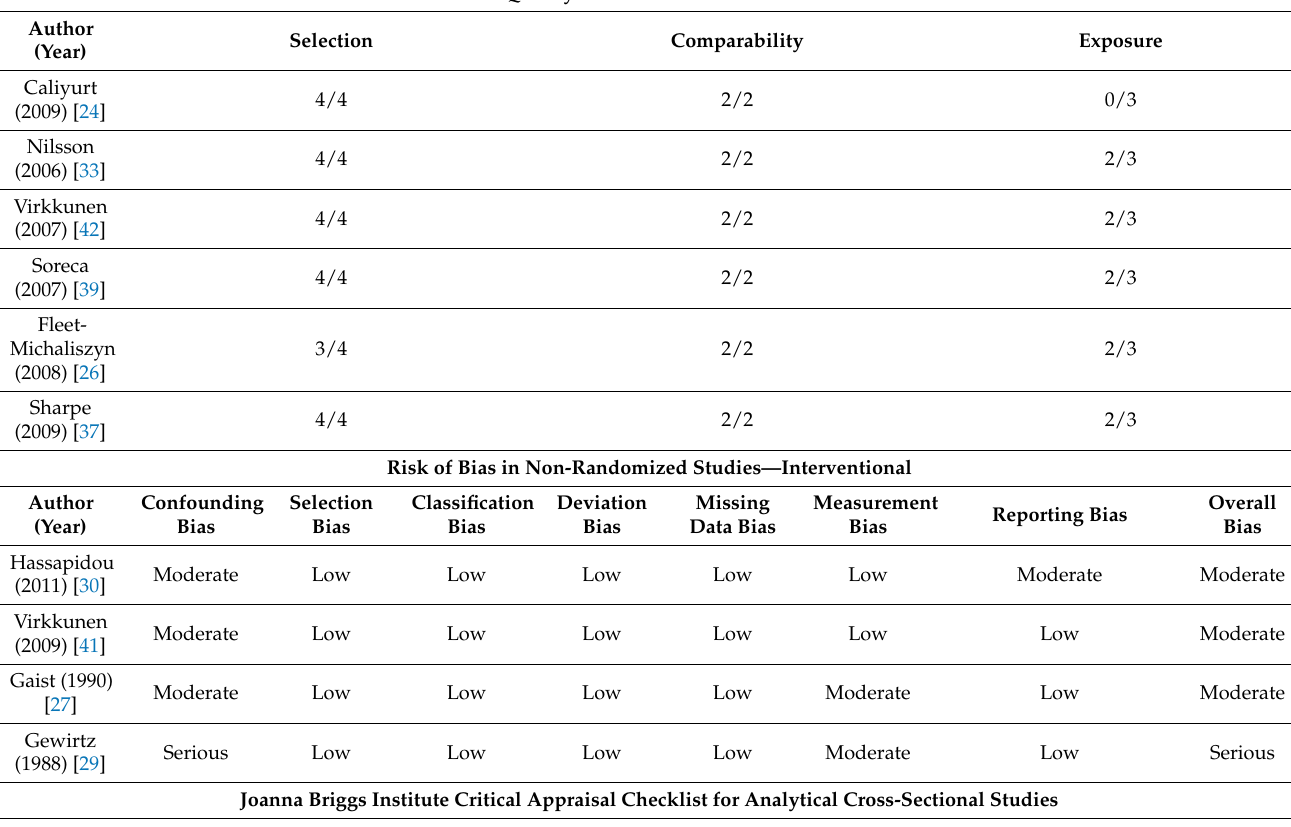
Table 1. Results of quality